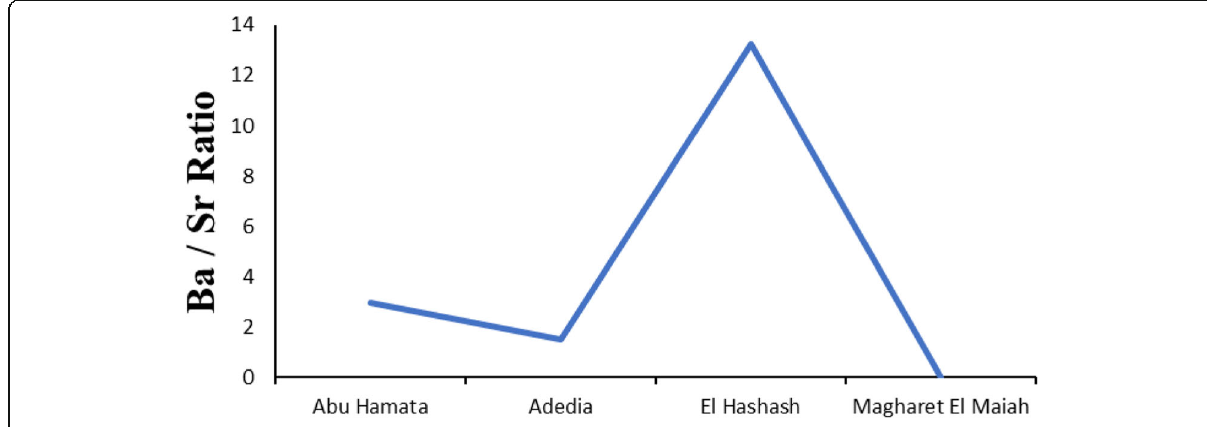
Fig. 13 Br/Sr ratio of the studied Paleozoic